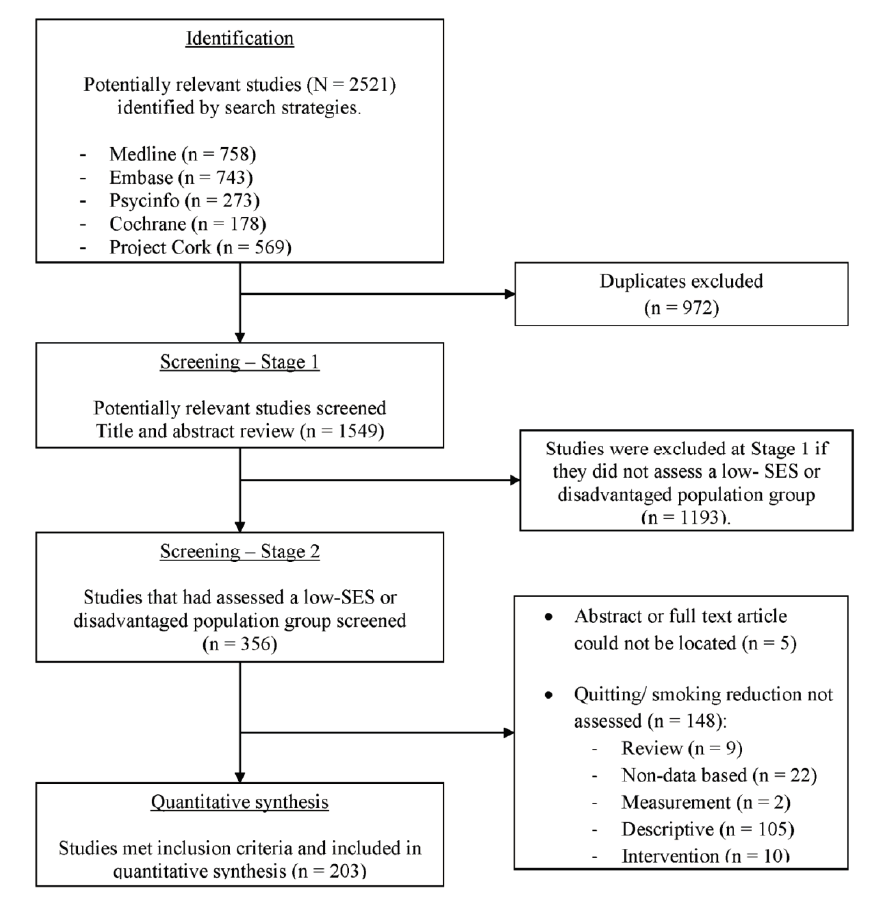
Figure 2. Flowchart of search strategy and selection criteria (2008–2012) using PRISMA